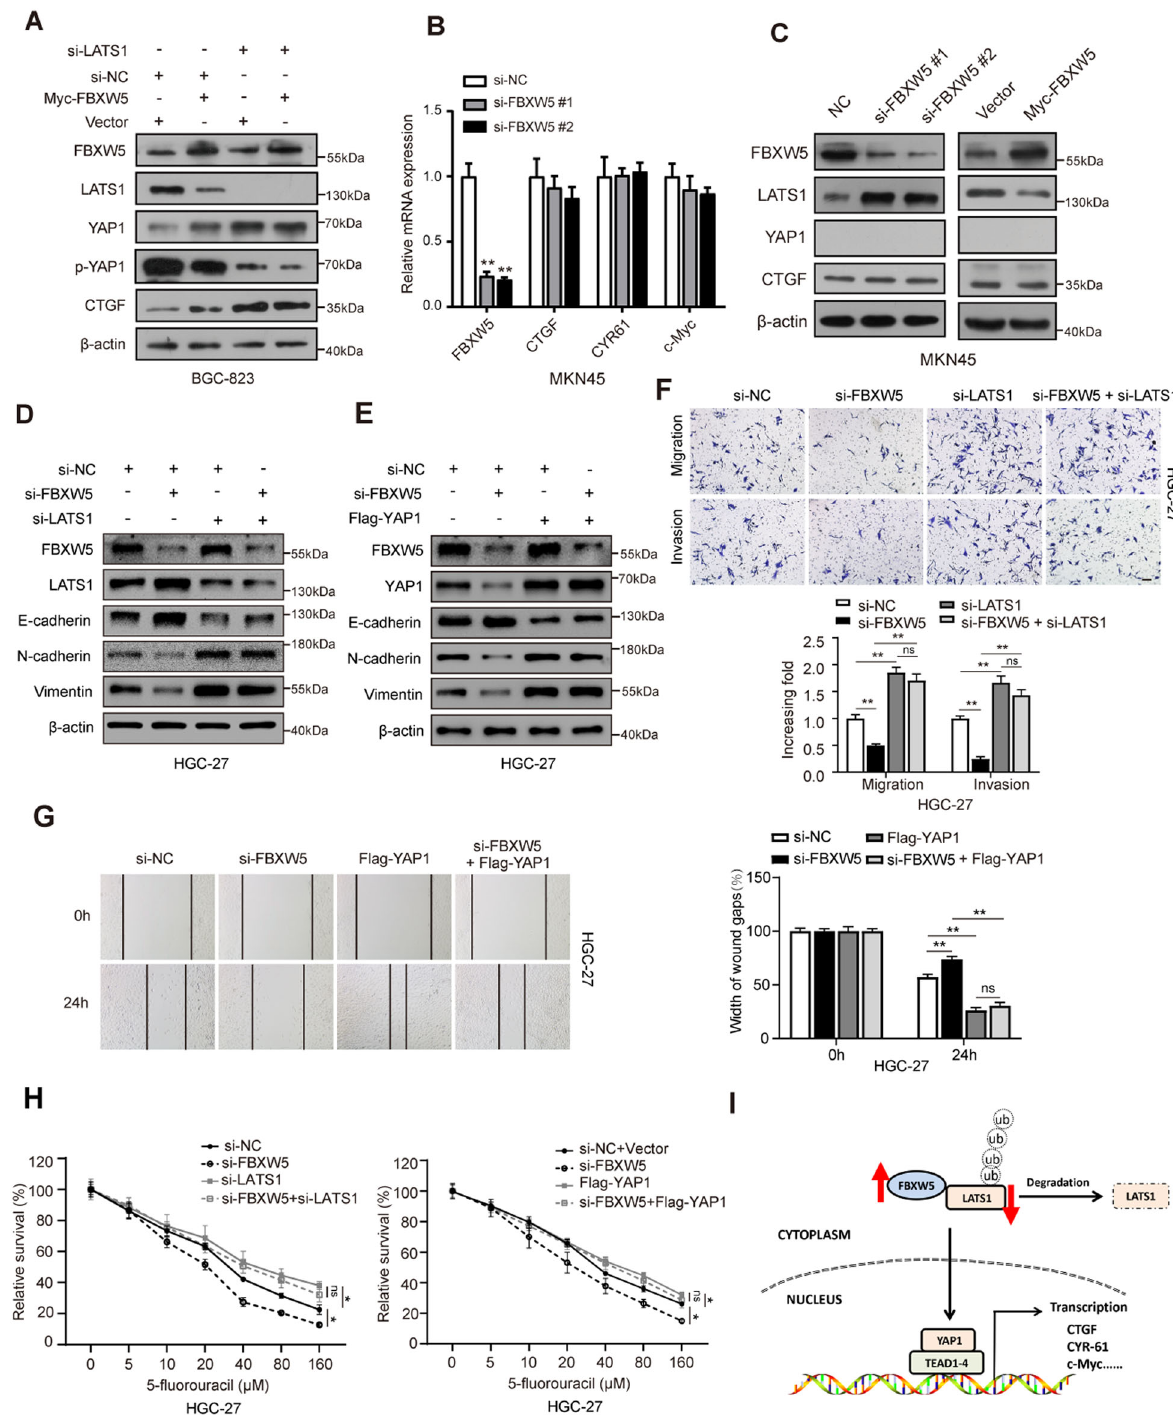
Fig. 7 Blocking LATS1-YAP1 leads to the loss of FBXW5-mediated regulation of the Hippo pathway and partial functions. A Silencing of LATS1 and upregulation of FBXW5 in BGC-823 cells. Western blot analysis was conducted to verify the effect of FBXW5 on the Hippo pathway during LATS1 de fi ciency. B RT-qPCR was carried out to determine the effect of FBXW5 knockdown on the downstream molecule of the Hippo pathway in MKN-45 cells. Data were presented as mean ± SEM from three biologically independent experiments. C Western blotting was performed using MKN-45 to determine the effect of FBXW5 on protein expression in the Hippo pathway. D , E Effects of FBXW5 silencing on the EMT protein after LATS1 knockdown or YAP1 supplementation. F , G After LATS1 knockdown or YAP1 supplementation, transwell and wound healing assays were conducted to determine the effect of FBXW5 on cell invasion and migration. The experiments were repeated three times with the most signi fi cant results presented. H After LATS1 knockdown or YAP1 overexpression, 5- fl uorouracil (5-FU) was added to the transfected cells for the chemo-sensitivity experiments. Thereafter, cell viabilities were determined using the CCK8 analysis. The experiments were repeated three times with the most signi fi cant results presented. I Schematic of FBXW5 participating in GC. Bar scale: 100 μ